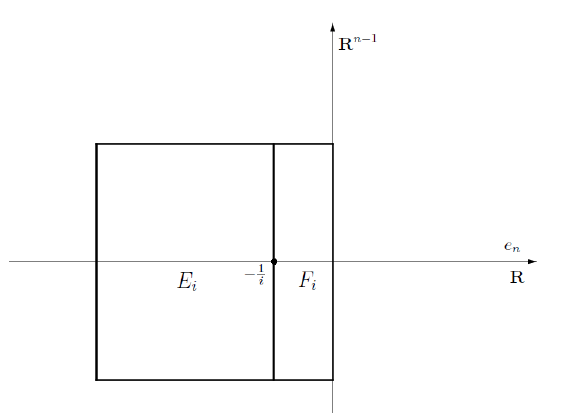
Figure 2: The sets E i and F